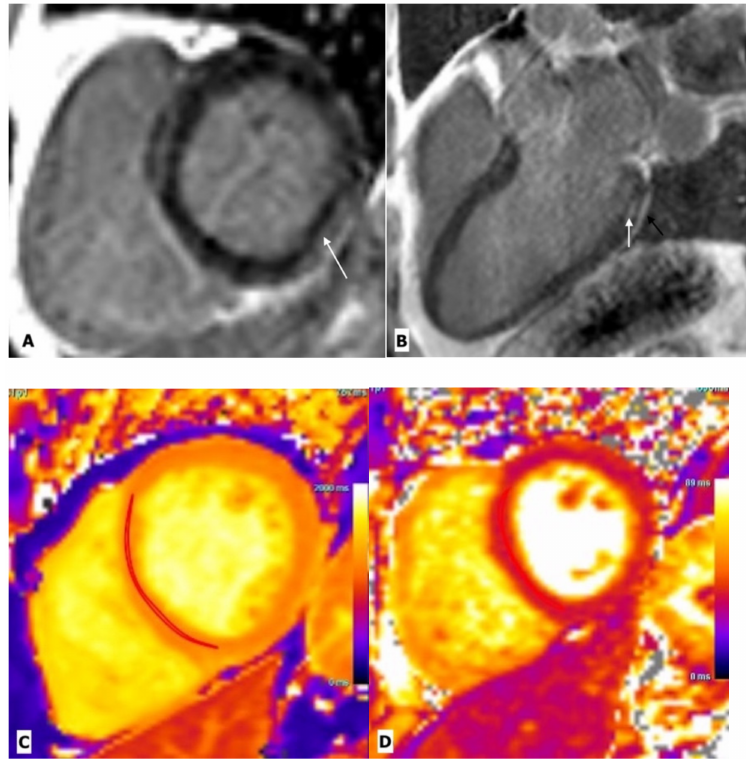
Figure 2. Cardiac magnetic resonance imaging in a 43-year-old man with HIV-related perimyocarditis. ( A ) Mid-ventricular short-axis and ( B ) 3-chamber long-axis images showing linear mid-wall enhance- ment in the basal inferior and inferolateral lateral walls (white arrows). The overlying pericardium also shows mild thickening and enhancement. ( C ) T1 map and ( D ) T2 map at the mid-LV show a markedly elevated myocardial T1 time of 1214 ms (normal 1104 ms at 3.0 Tesla) and T2 time of 44 ms (normal 37.4 ms at 3.0 Tesla) consistent with diffuse myocardial